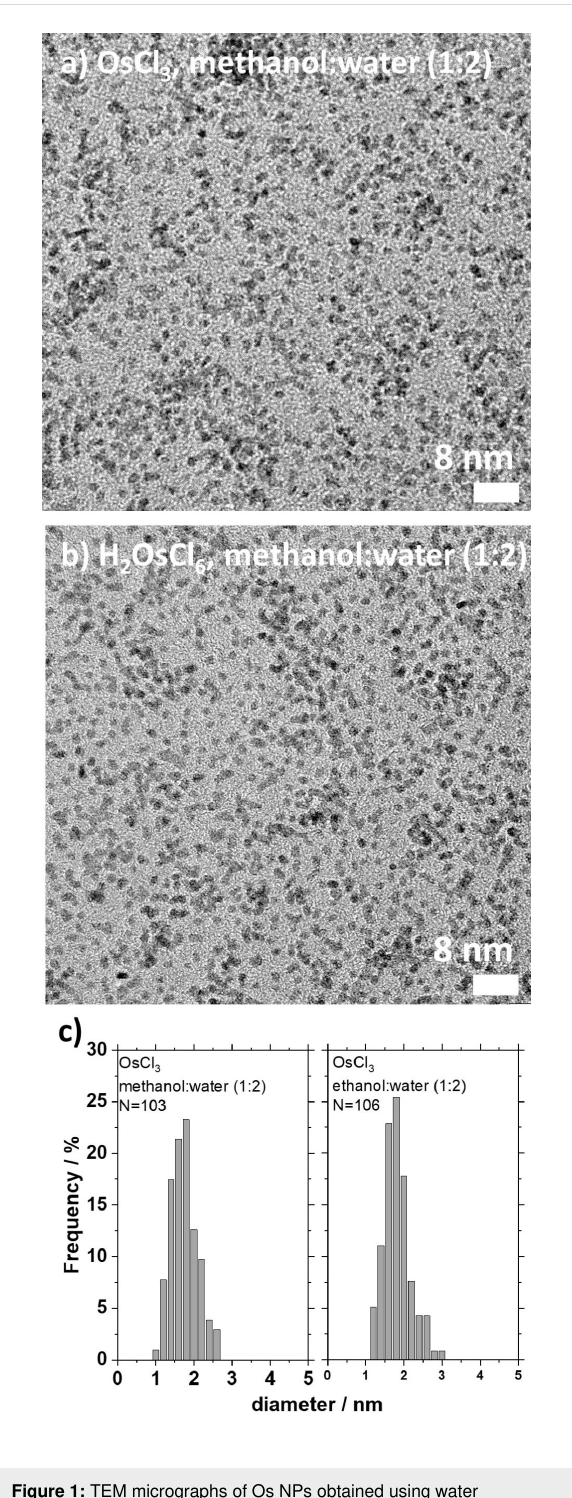
Figure 1: TEM micrographs of Os NPs obtained using water (66 vol %) and methanol (33 vol %), no base, and 100 mM of (a) OsCl 3 and (b) H 2 OsCl 6 as precursors after a one-week reaction at 85 °C in nuclear magnetic resonance (NMR) tubes (volume approx. 0.2 mL). The size analysis suggests that the NPs are (a) 1.6 ± 0.4 nm and (b) 1.7 ± 0.3 nm. The size distribution is presented in (c) from the anal- ysis of 103 and 106 NPs, respectively.